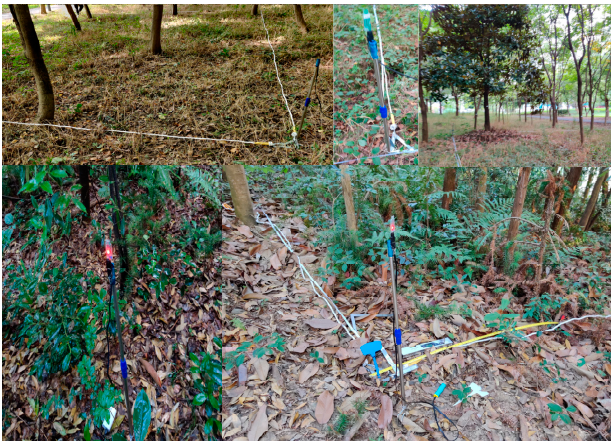
Figure 6. An example to show the anchor installation in a plot.